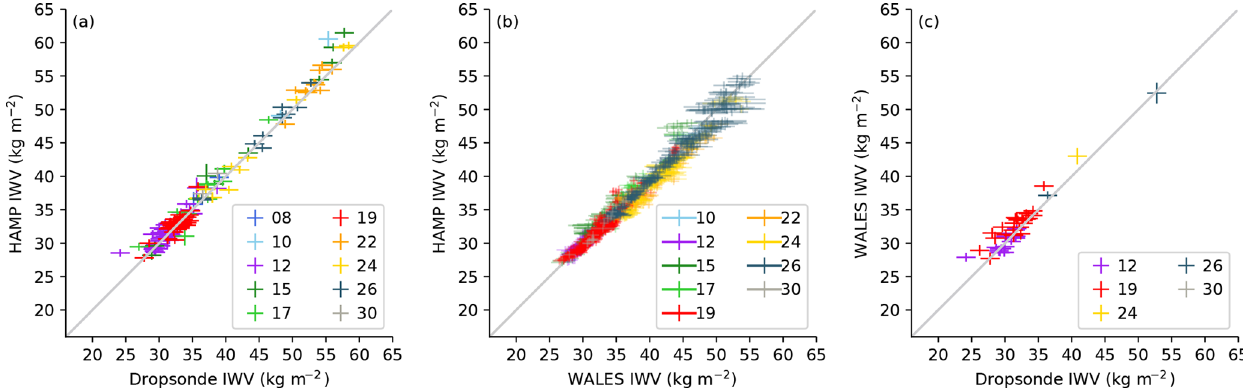
Figure 5. IWV comparison of HAMP MWR and dropsondes (a) , HAMP MWR and WALES (b) , and WALES and dropsondes (c) during NARVAL2. The colors indicate the flight days in August 2016. Scores are given in Table